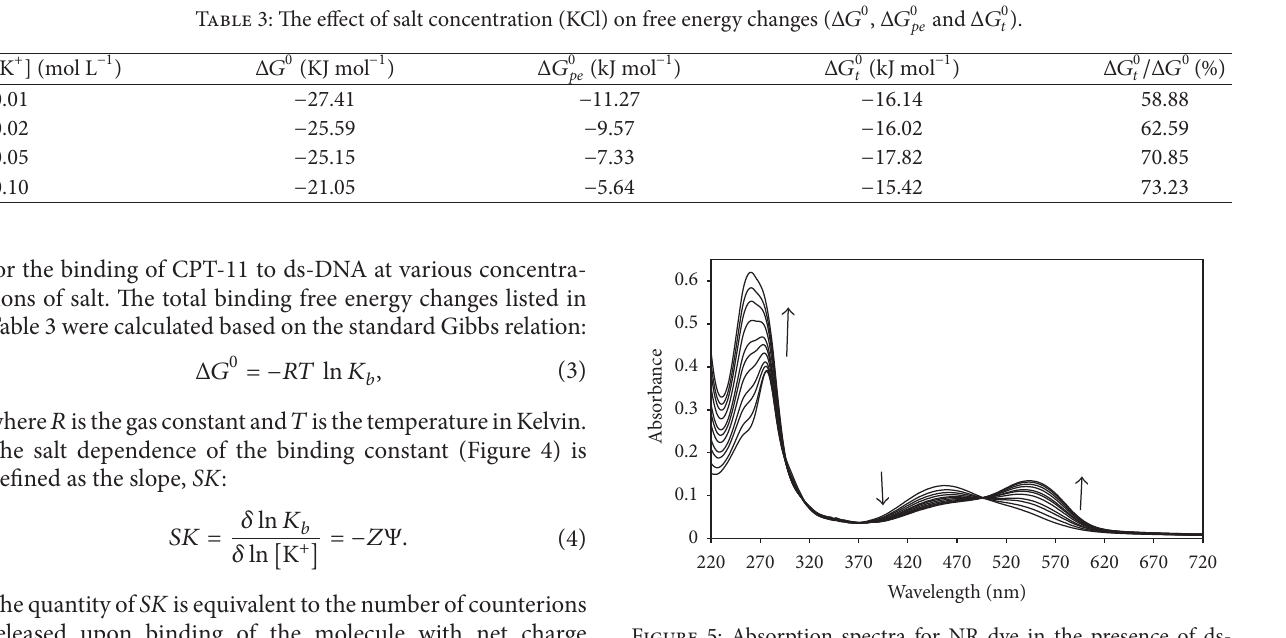
F 5: Absorption spectra for NR dye in the presence of ds- DNA at different concentrations. 33.5, 40.2, 46.9, 53.6, 60.3, and 67.0